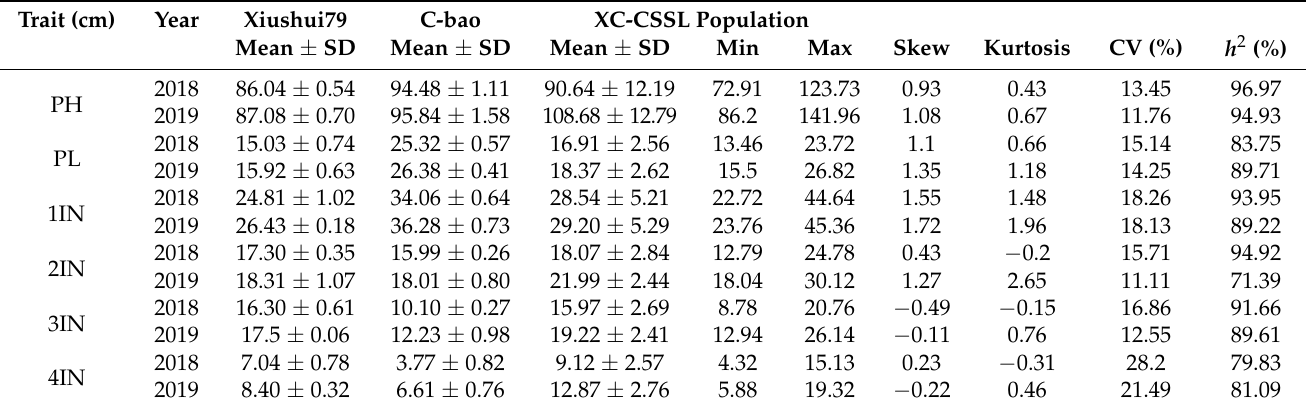
Table 2. Descriptive statistics of phenotypic variations in XC-CSSL population and its parents in two